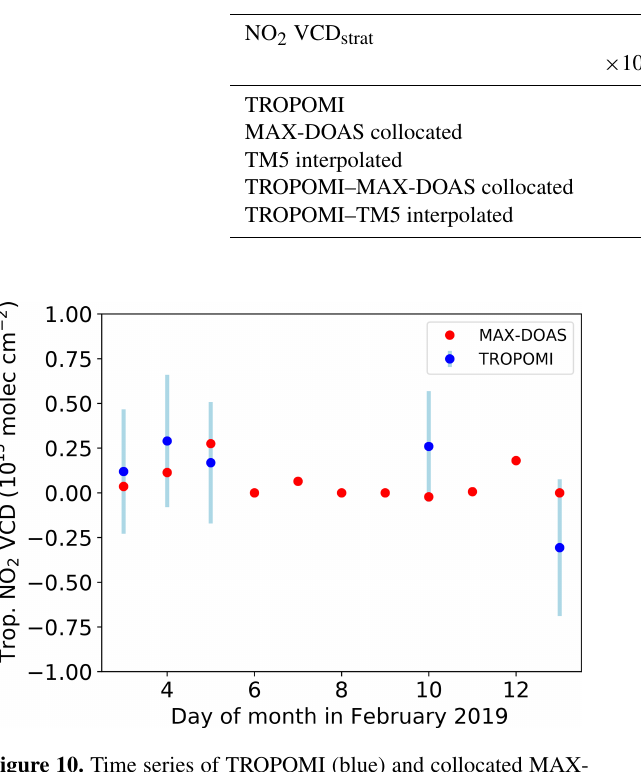
Figure 11. Scatter plot of TROPOMI tropospheric NO 2 vertical col- umn densities versus MAX-DOAS tropospheric NO 2 vertical col- umn densities for all cruises. The MAX-DOAS measurements are taken from the collocated TROPOMI pixels. The vertical error bar shows the precision of the TROPOMI data; the horizontal error bar shows the uncertainty of the MAX-DOAS